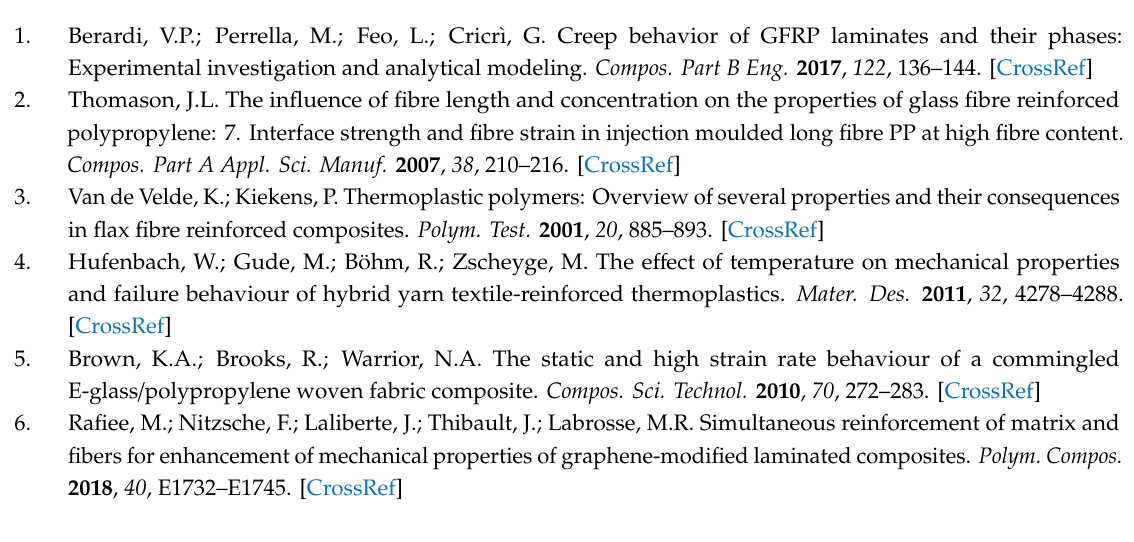
Figure S1: the density profile of glass fiber–PP interface at di ff erent loading temperatures; Figure S2: the density profile of glass fiber–PP interface at di ff erent strain